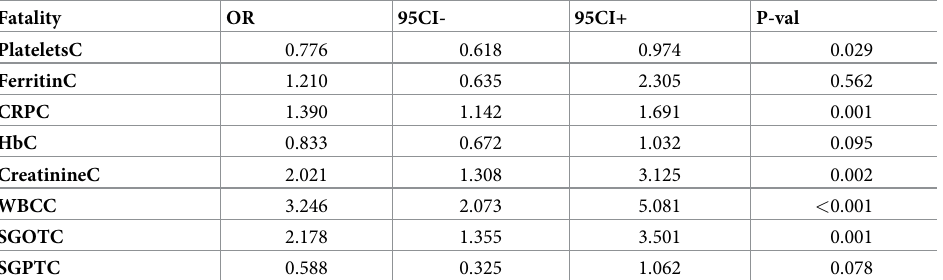
Table 9. Binomial logistic regression coefficients of continuous variables predicting fatality from joint blood pan- els as exposures.